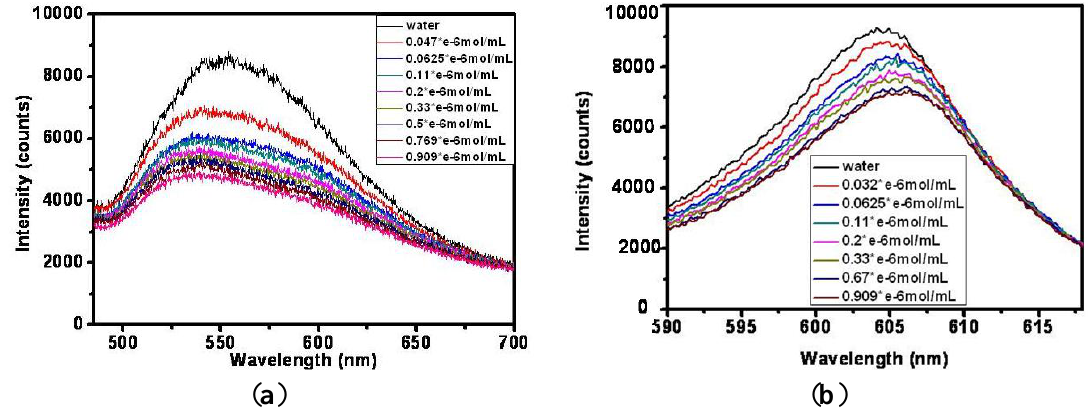
Figure 7. Spectra of varying concentrations of methylene blue under ( a ) visible light; ( b ) red light.